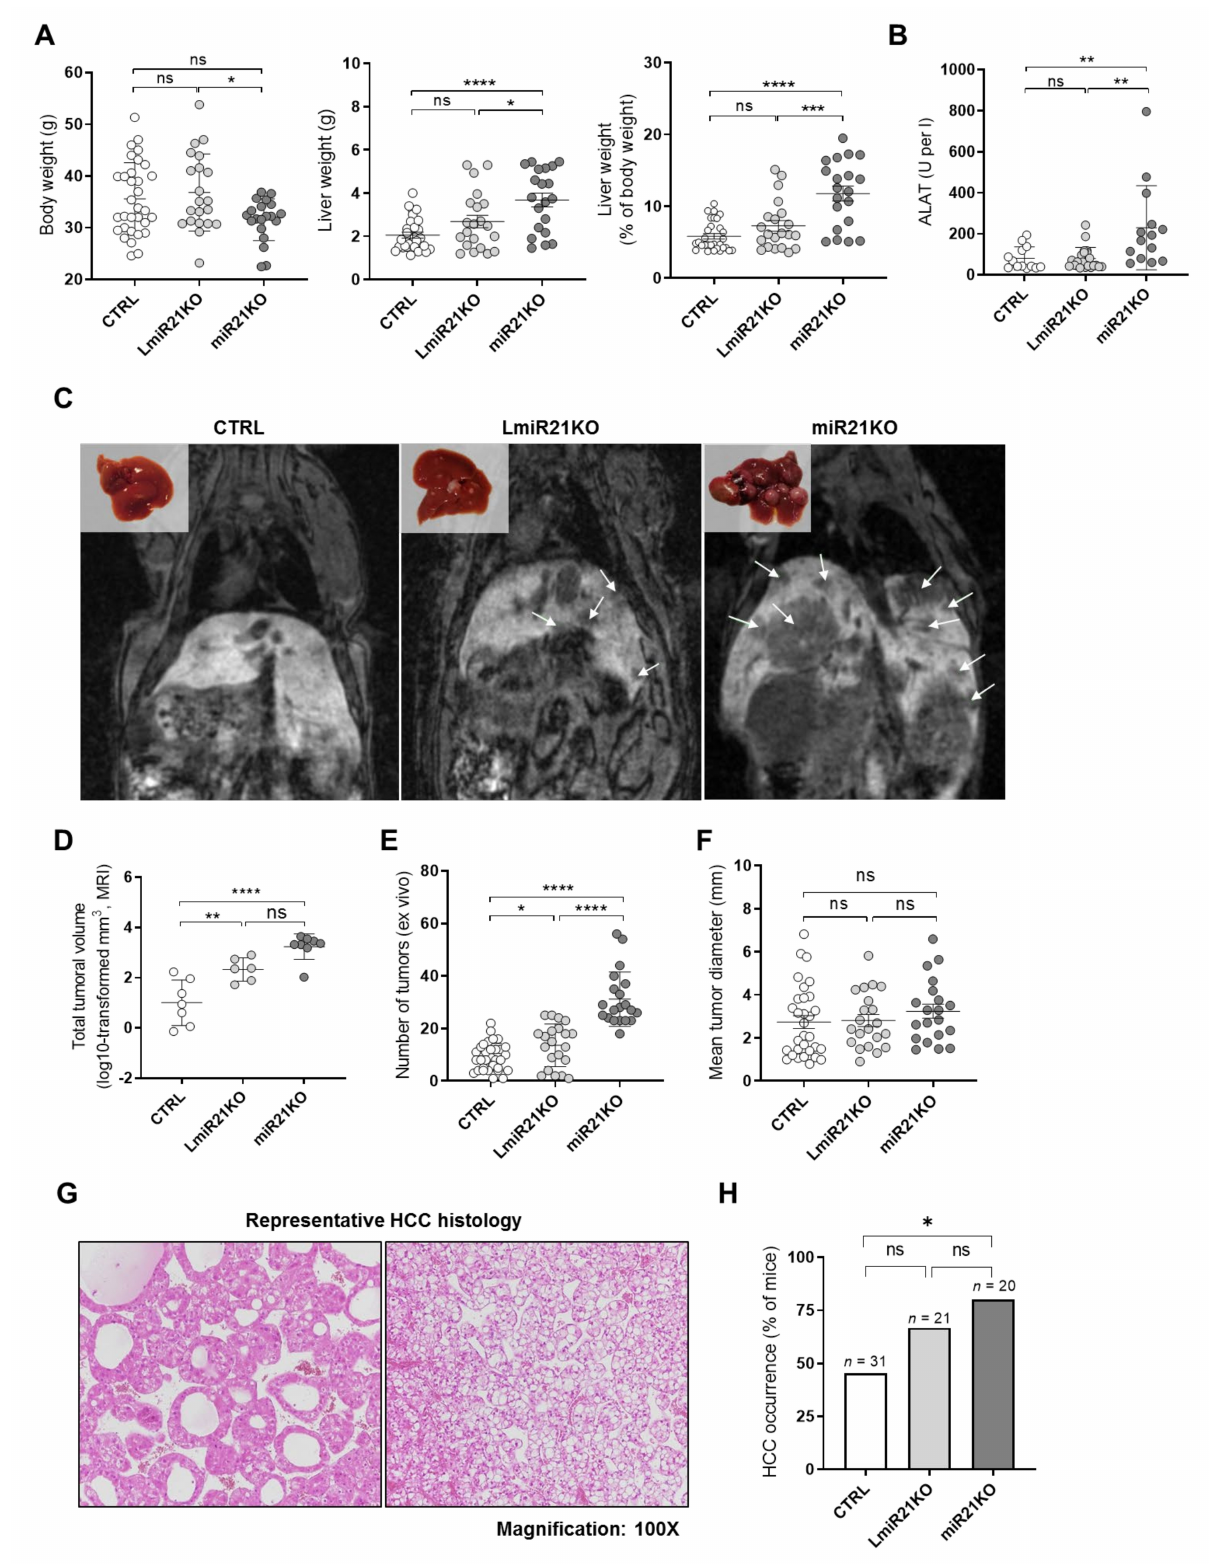
Figure 2. MiR-21 deficiency fosters DEN-induced HCC development. ( A ) Body weight, liver weight, and liver-to-body weight ratio of 11-month-old control (CTRL—miR21fx, n = 32), hepatocyte-specific and total miR-21 knockout